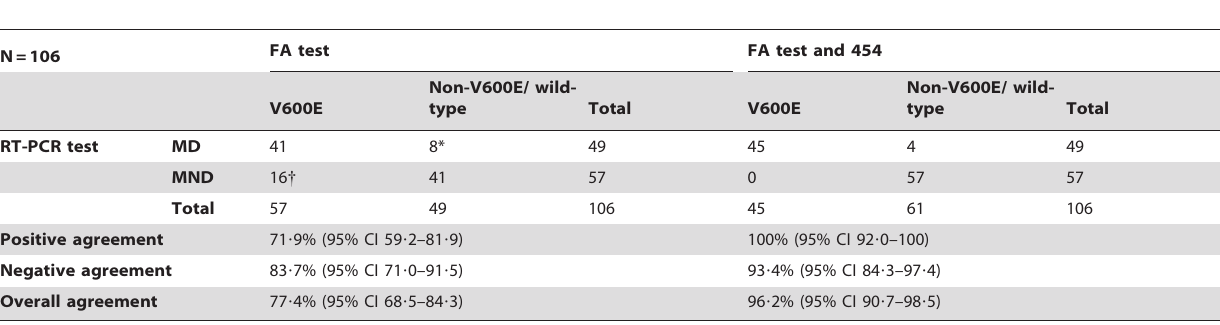
Table 4. Methods correlation between RT-PCR test and FA test sequencing at Site 2 and after 454 sequencing of discrepant specimens.